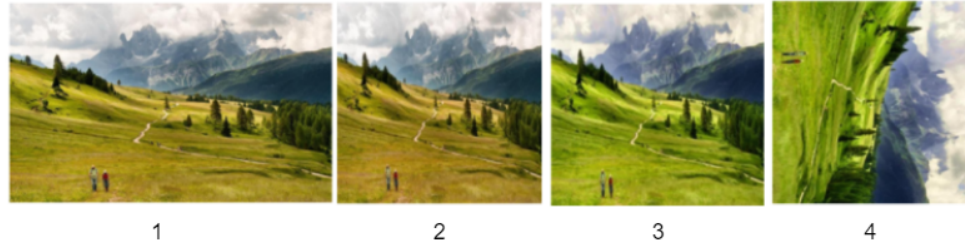
Figure 29. GAN Training Samples Augmented (first